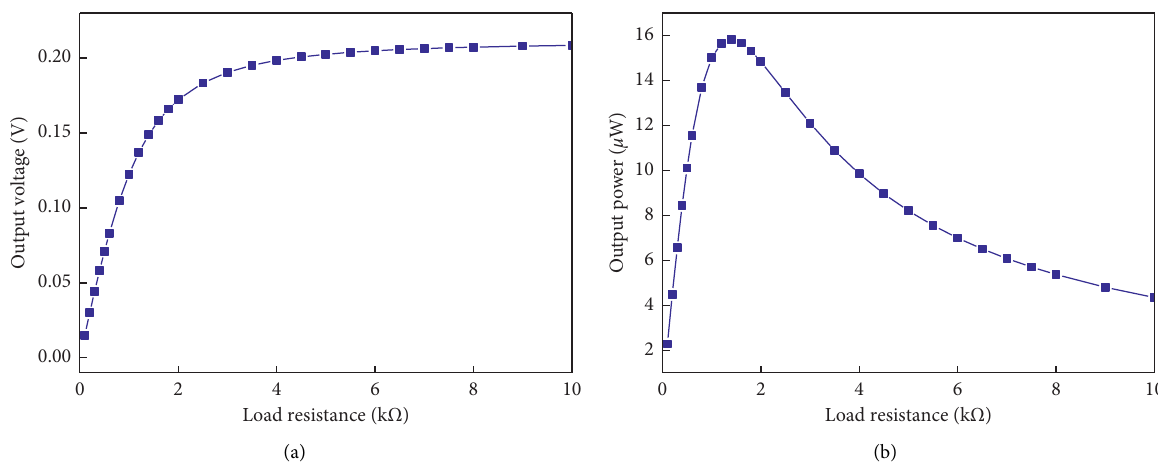
Figure 13: Voltage and power response with different resistance: (a) resistance-voltage curve and (b) resistance-power